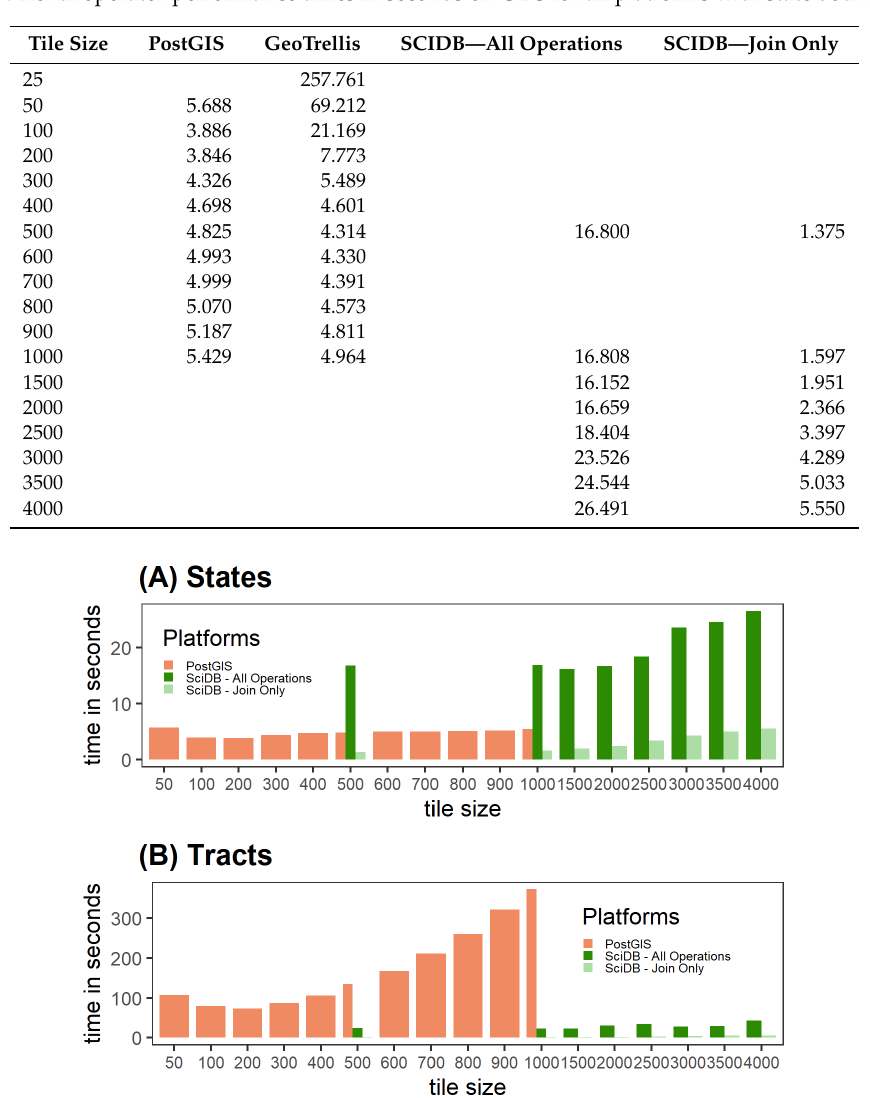
Table 9. Zonal operator performance times in seconds on GLC for all platforms with state boundaries.